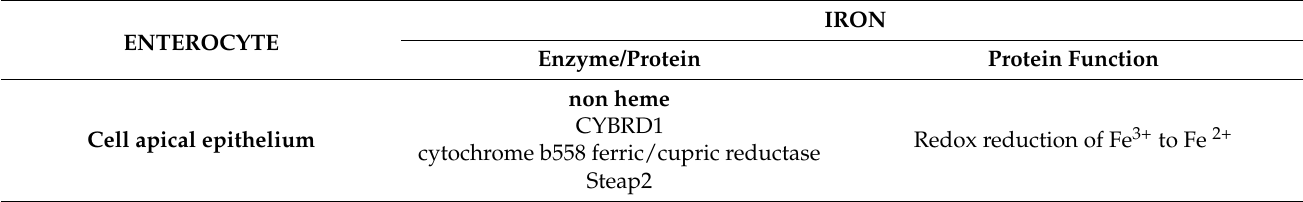
Table 1. Iron absorption and